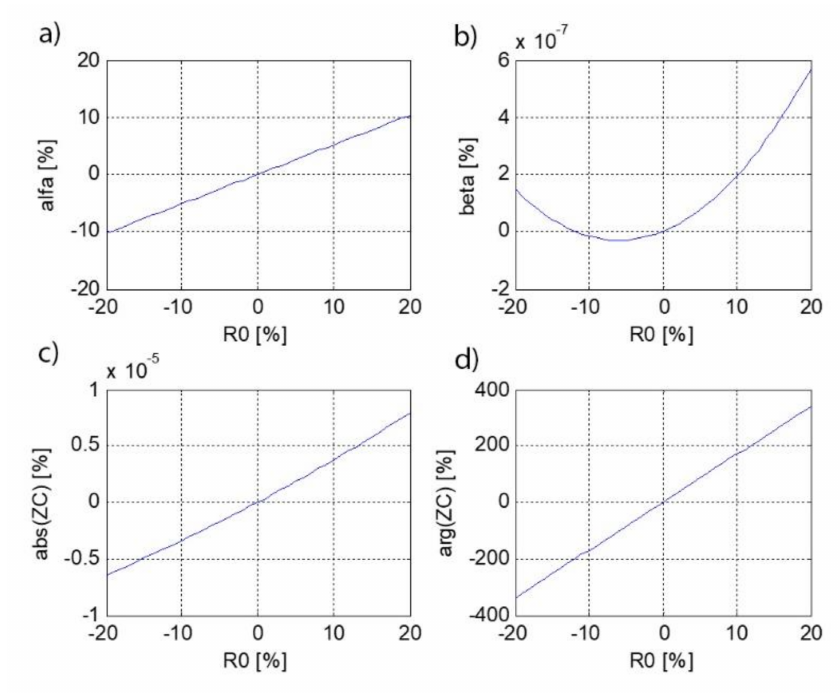
Figure 4. Changes of wave parameters depending on R 0 at f = 1 MHz; ( a ) damping factor α , ( b ) phase factor β , ( c ) wave impedance modulus, and ( d ) wave impedance